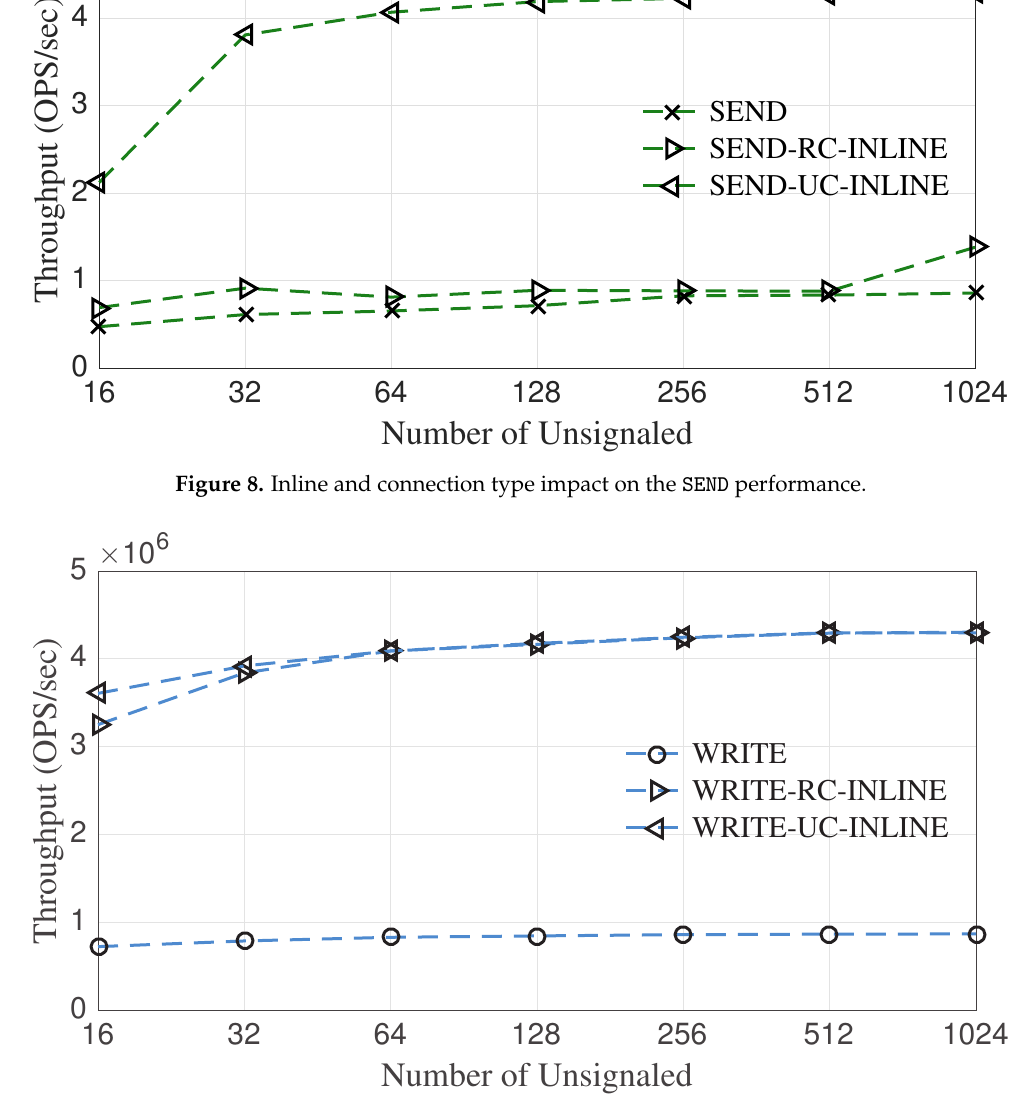
Figure 9. Inline and connection type impact on the WRITE